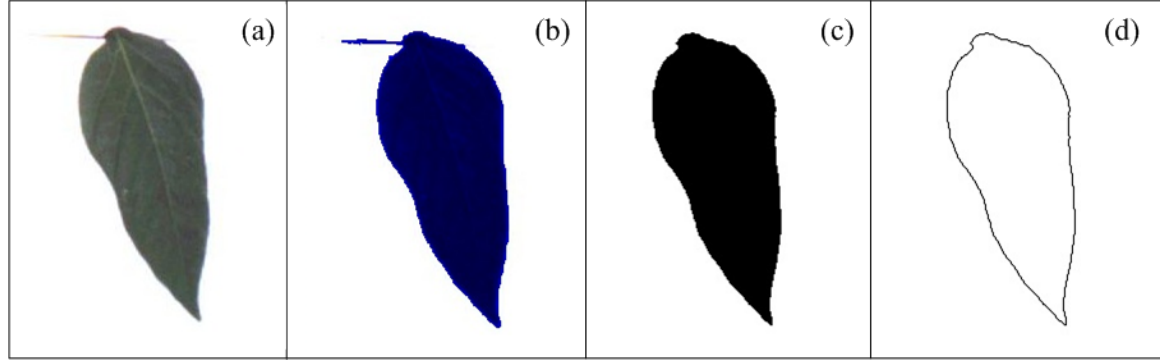
Figure 8. ( a ) Original pepper leaf. ( b ) Blue component of pepper leaf. ( c ) Leaf area segmentation ( d ) Leaf perimeter